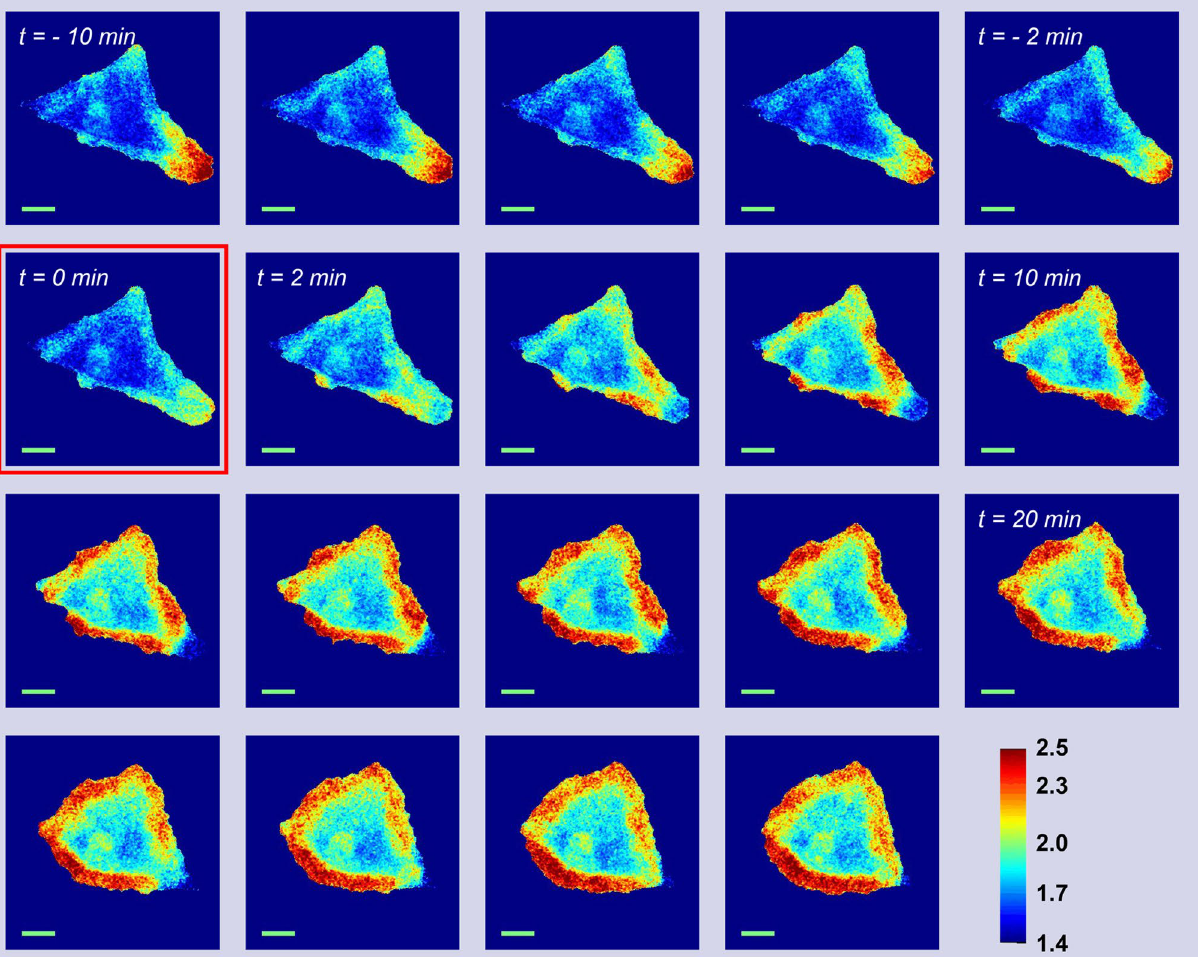
Figure 3. Live-cell imaging of Rac1 biosensors. Representative image series of a HeLa cell co-expressing the FP Rac1 sensor with the 20 nm ER/K linker (transient transfection) and RapR-Src constructs (stable transfection) was imaged at two-minute intervals. The first image obtained following rapamycin addition (500 nM) is indicated by the square (at t = 0). The montage shows FRET/mCerulean ratio images with warmer colors reflecting higher localized Rac1